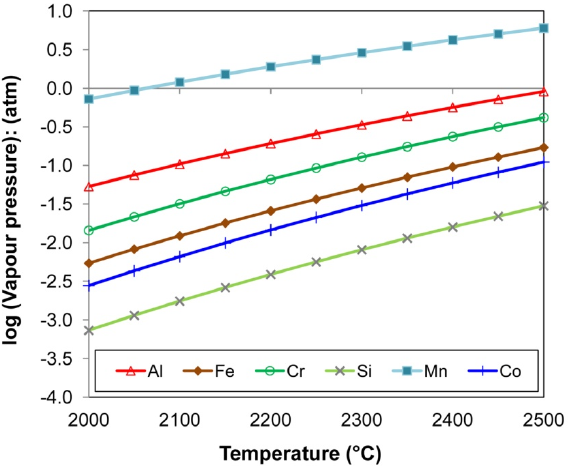
Figure 7. Vapour pressure of pure metals Mn, Al, Cr, Fe, Co, Si vs. Temperature.